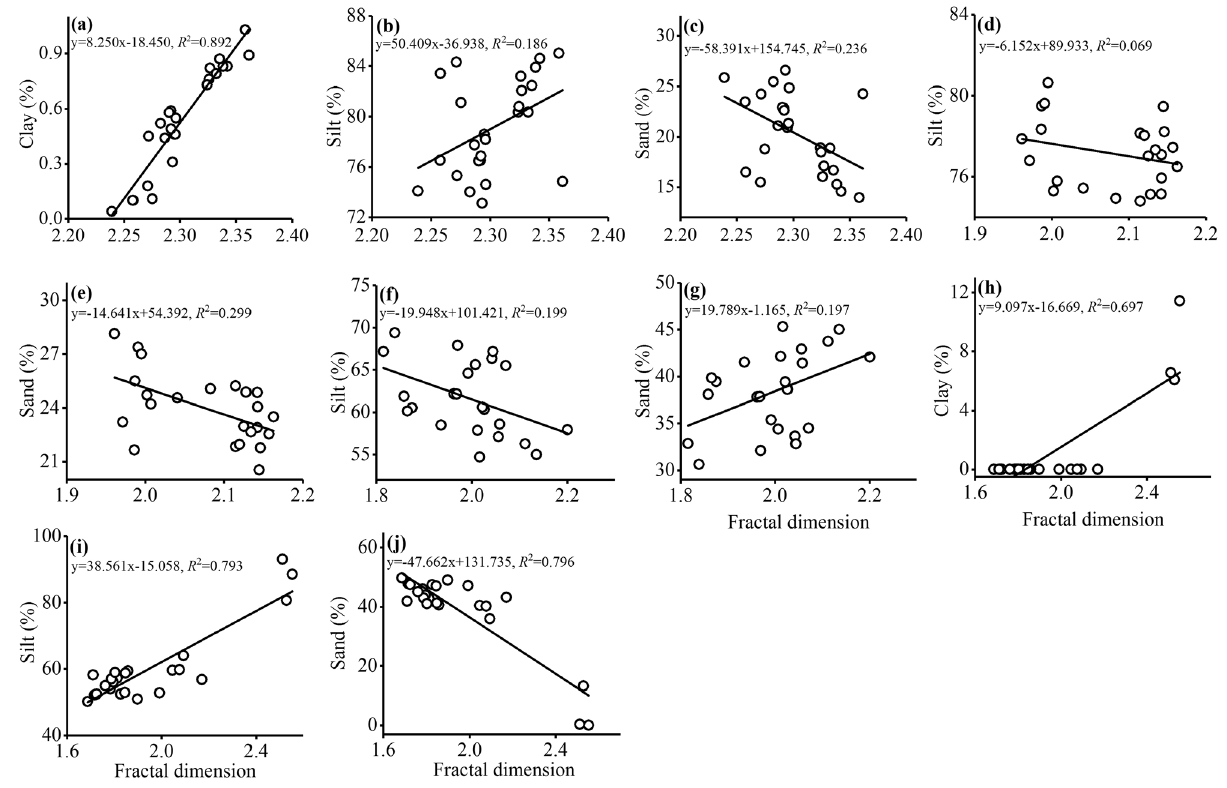
Figure 4. Linear regression relationships between the fractal dimension and the clay, silt, and sand contents at the different sites (Qiemo: a – c , a : r = 0.94, p < 0.01, n = 25; b : r = 0.43, p < 0.05, n = 25; c : r = − 0.49, p < 0.05, n = 25; Qira: d , e , d : r = − 0.01, p > 0.05, n = 25; e : r = − 0.01, p > 0.05, n = 25; Aral: f , g , f : r = − 0.45, p < 0.05, n = 25; g : r = 0.45, p < 0.05, n = 25; and Tazhong: h – j , h : r = 0.75, p < 0.01, n = 4; i : r = 0.79, p < 0.01, n = 25; j : r = − 0.79, p < 0.01, n = 24).